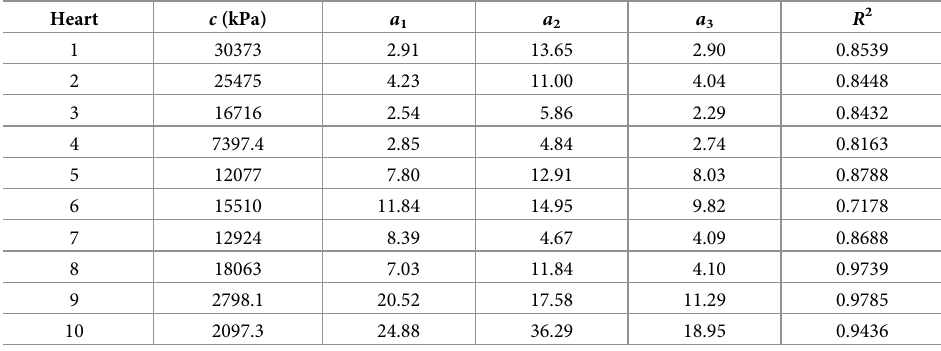
Table 3. Post-elastase fitting parameters for Fung-type SEF.